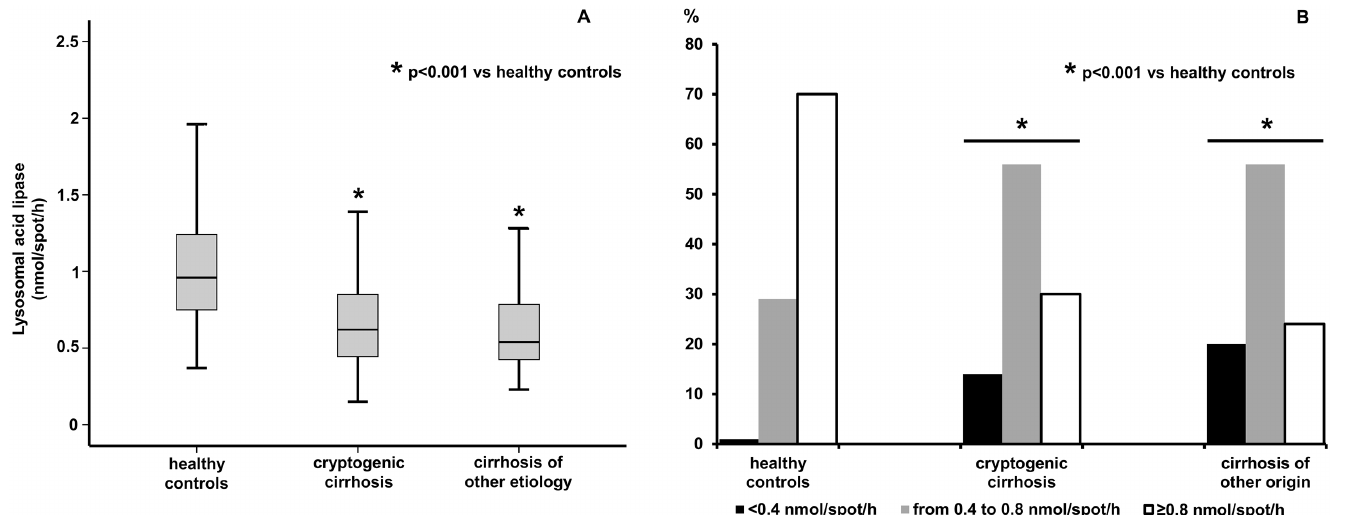
Fig 1. DBS-determined LAL activity in cryptogenic cirrhotics, cirrhotics of known etiology and healthy subjects (Panel A). Percentages of cirrhotic patients and healthy subjects with normal ( (cid:1) 0.8 nmol/spot/h), mildly reduced (range 0.4 – 0.8 nmol/spot/h), or severely reduced LAL activity ( < 0.4 nmol/ spot/h) (Panel